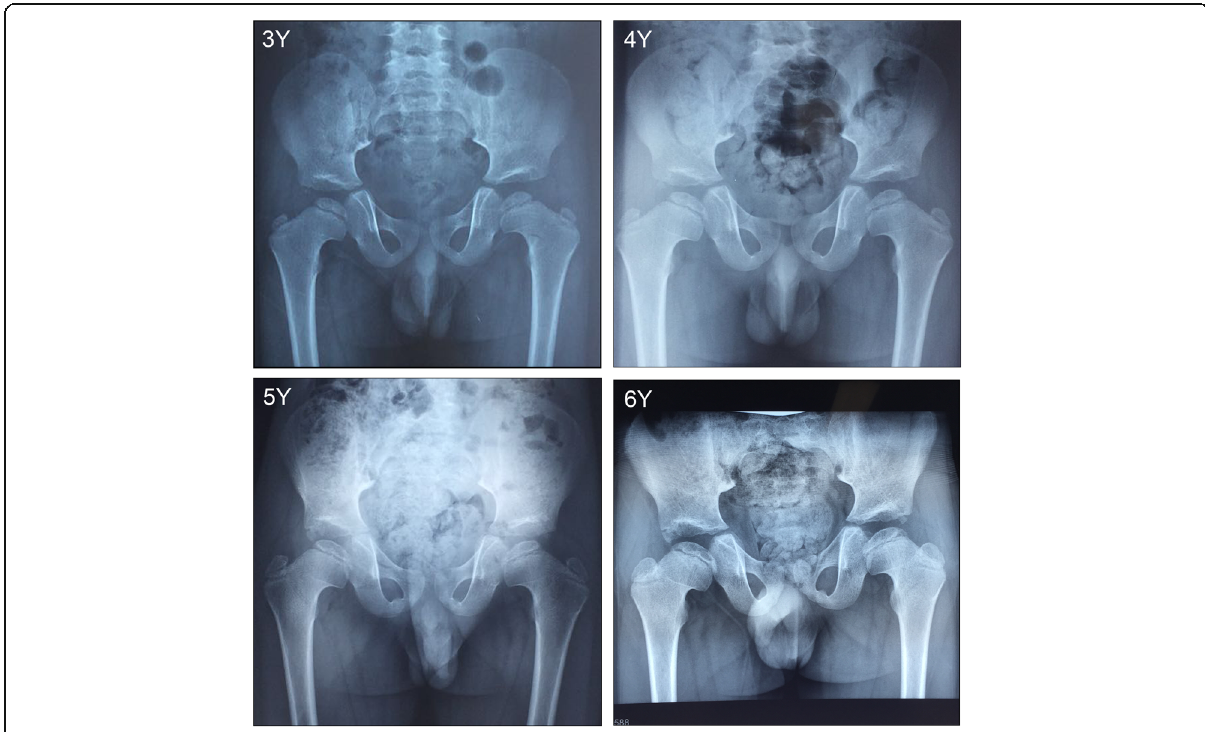
Fig. 2 Hip radiographs of patient 2 during the ages from 3 to 6 years. Roentgenologic bone survey showed hip dysplasia with the following abnormalities: both femoral necks were short with flattened heads, acetabulum dysplasia, and secondary ossification center of femur